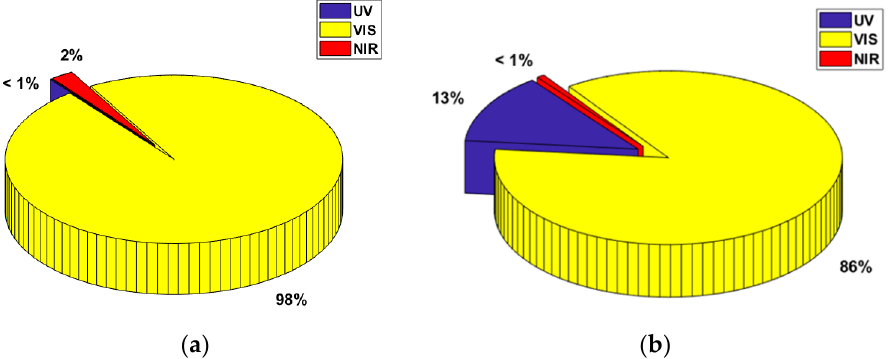
Figure 8. Percentage of optical radiation energy for electrical discharges generated in mineral oil, Orlen Trafo EN, on electrode systems: needle–needle ( a ) and for surface discharges ( b ).